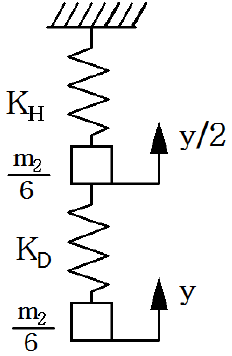
Figure 5. Spring-mass diagram of the amplifier.